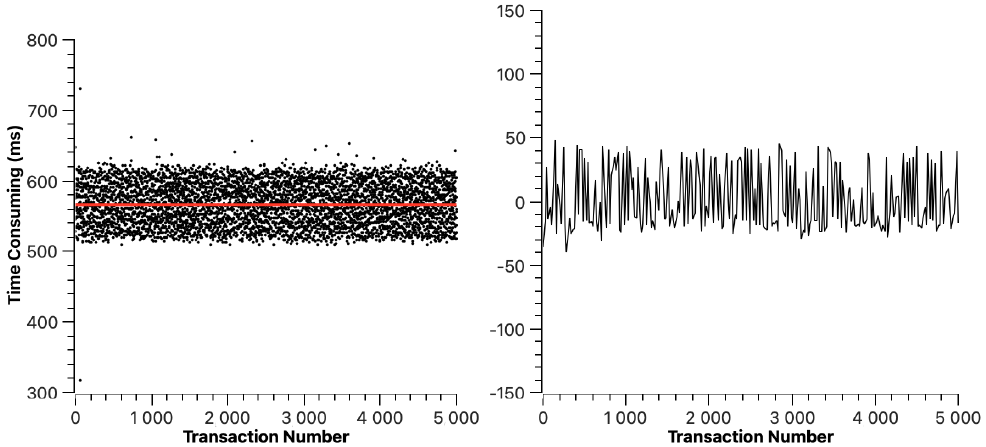
Figure 7. Fisco BCOS cross-chain transaction resolution